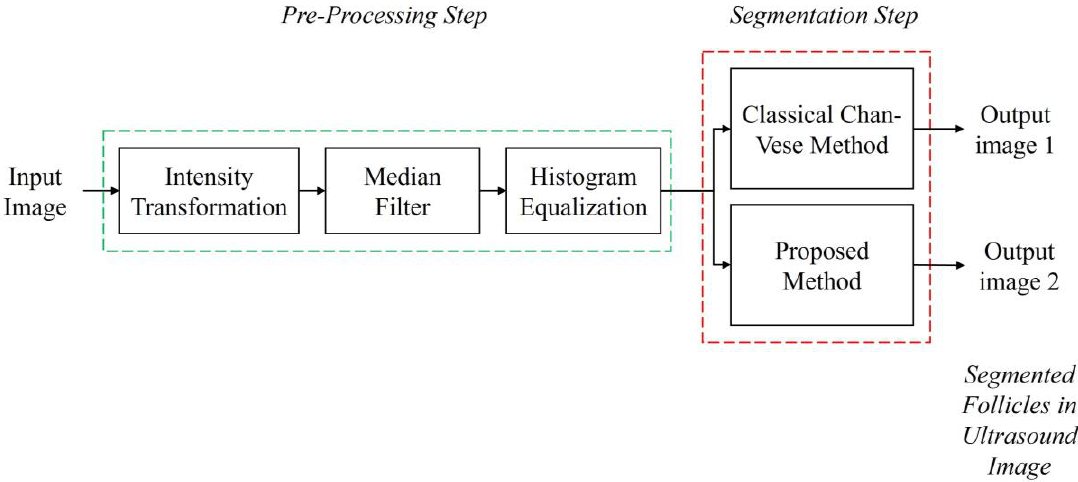
Figure 3. Flow diagram of the study.